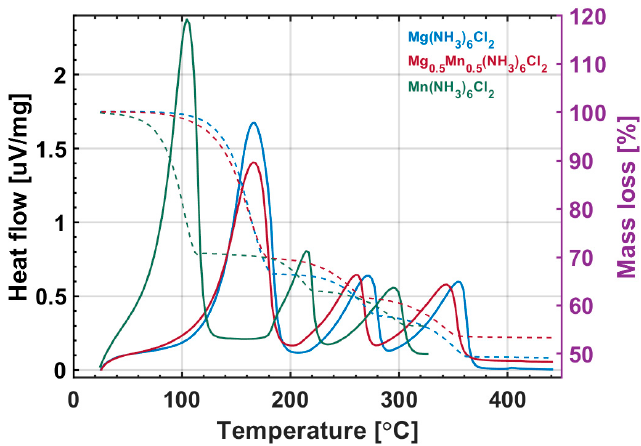
Figure 3. TGA-DSC of Mg(NH 3 ) 6 Cl 2 , Mg 0.5 Mn 0.5 (NH 3 ) 6 Cl 2 and Mn(NH 3 ) 6 Cl 2 measured from RT to 450 °C, Δ T/ Δ t = 5 °C ⋅ min -1 .